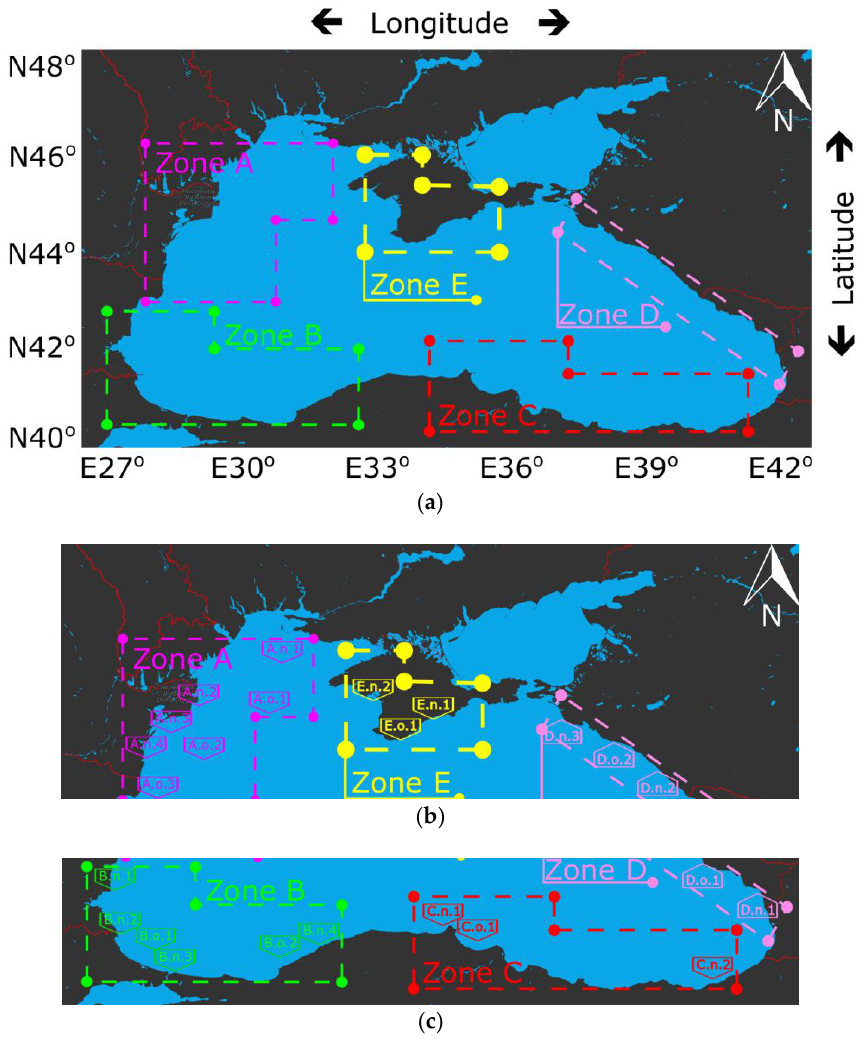
Figure 1. The geographical locations of the reference points corresponding to the 5 zones considered: zone A (shallow water points: A.n.1 to A.n.4 and deep water points: A.o.1 to A.o.3), zone B (shallow water points: B.n.1 to B.n.4 and deep water points: B.o.1 and B.o.2), zone C (shallow water points C.n.1 and C.n.2 and deep water point C.o.1), zone D (shallow water points: D.n.1 to D.n.3, deep